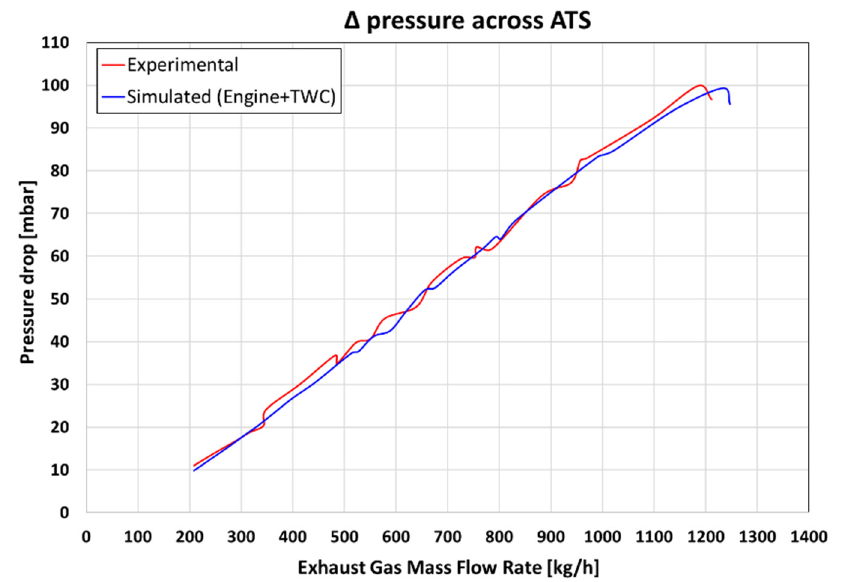
Figure 10. Pressure drop across TWC.